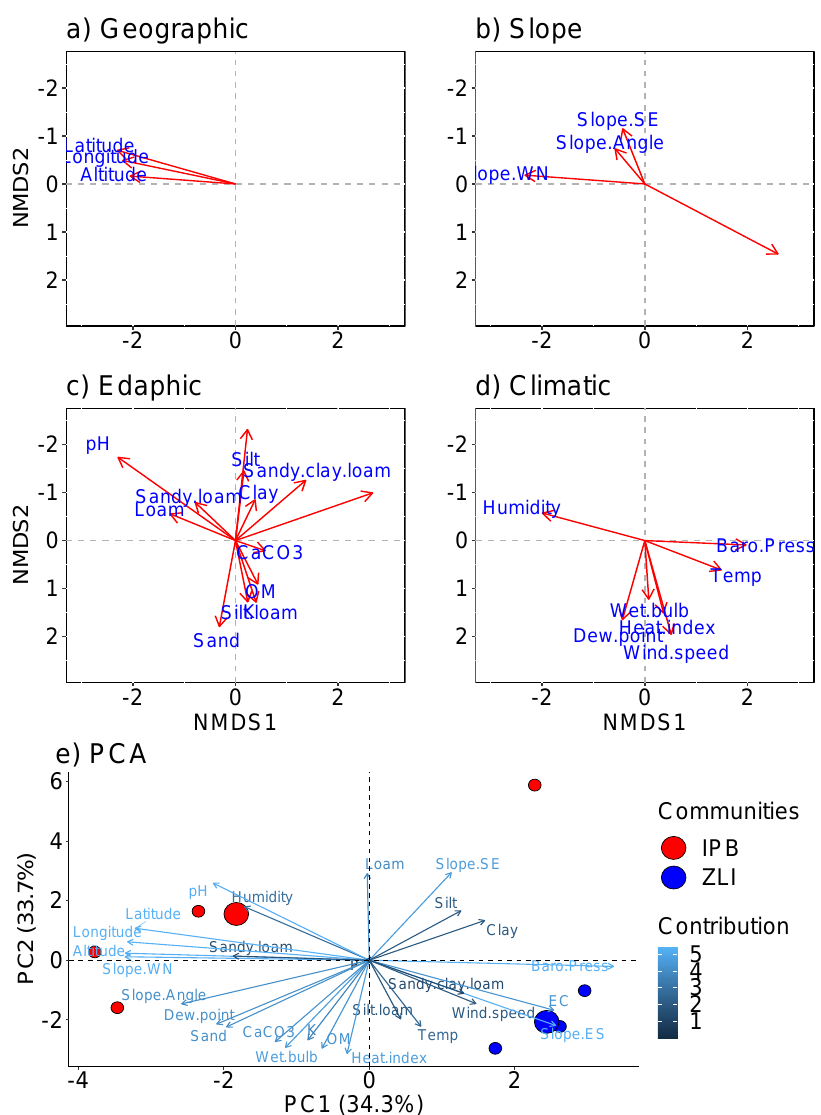
Figure 5. Multivariate analyses among plant communities of Himalayan Subtropical-Temperate Ecotone/Evergreen Oak Forest and ecological gradients. ( a – d ), Non-Multidimensional Scaling (NMDS) among vegetation communities and geographic ( a ), slope ( b ), edaphic ( c ), and climatic ( d ) gradients. ( e ) Principal Component Analysis (PCA) ordination of two plant communities along the ecological gradients. Species contribution analysis for community ordination in NMDS is depicted in Table 1. IPB: Indigofera-Parrotiopsis-Bistorta and ZLQ: Ziziphus-Letopus-Quercus . Table 1. Species contribution analysis for the site distribution pattern, referred to as intrinsic varia- bles. Significant species are displayed in bold.